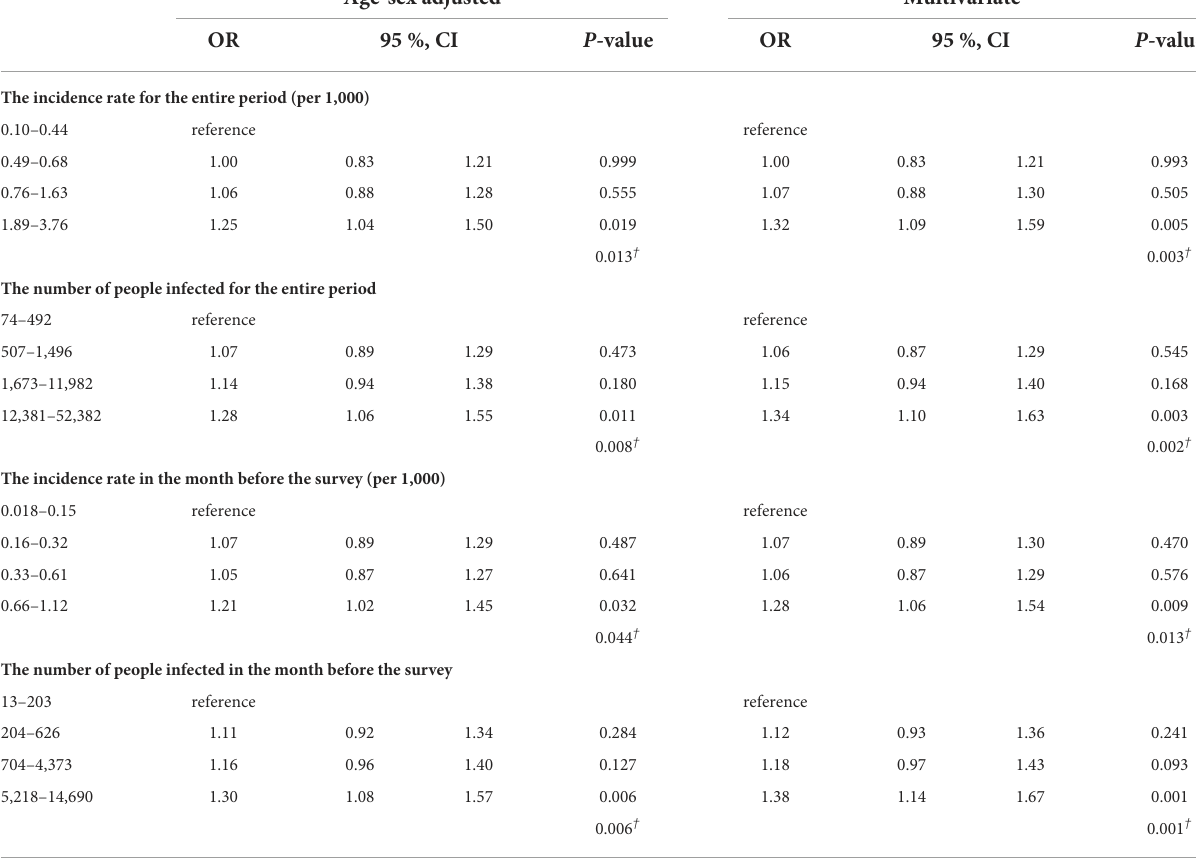
TABLE 3 Association between regional COVID-19 infection level and treatment interruption. Age-sex adjusted Multivariate * OR 95 %, CI P -value OR 95 %, CI P